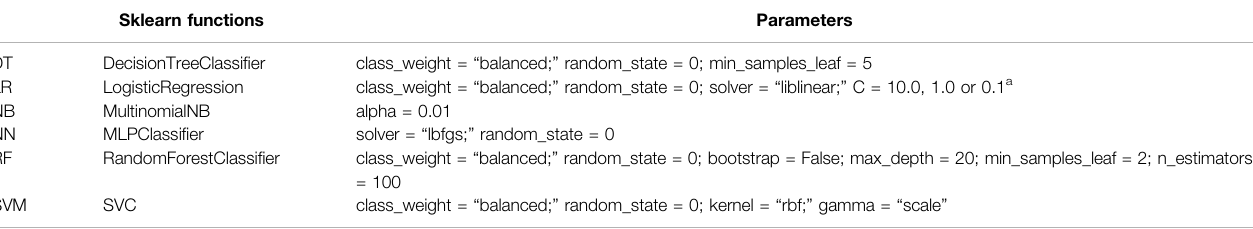
TABLE 1 | Scikit-learn functions and parameters for each algorithm: Decision Tree (DT), Logistic Regression (LR), Naïve Bayes (NB), Neural Network (NN), Random Forest (RF) and Support Vector Machine (SVM). Sklearn functions